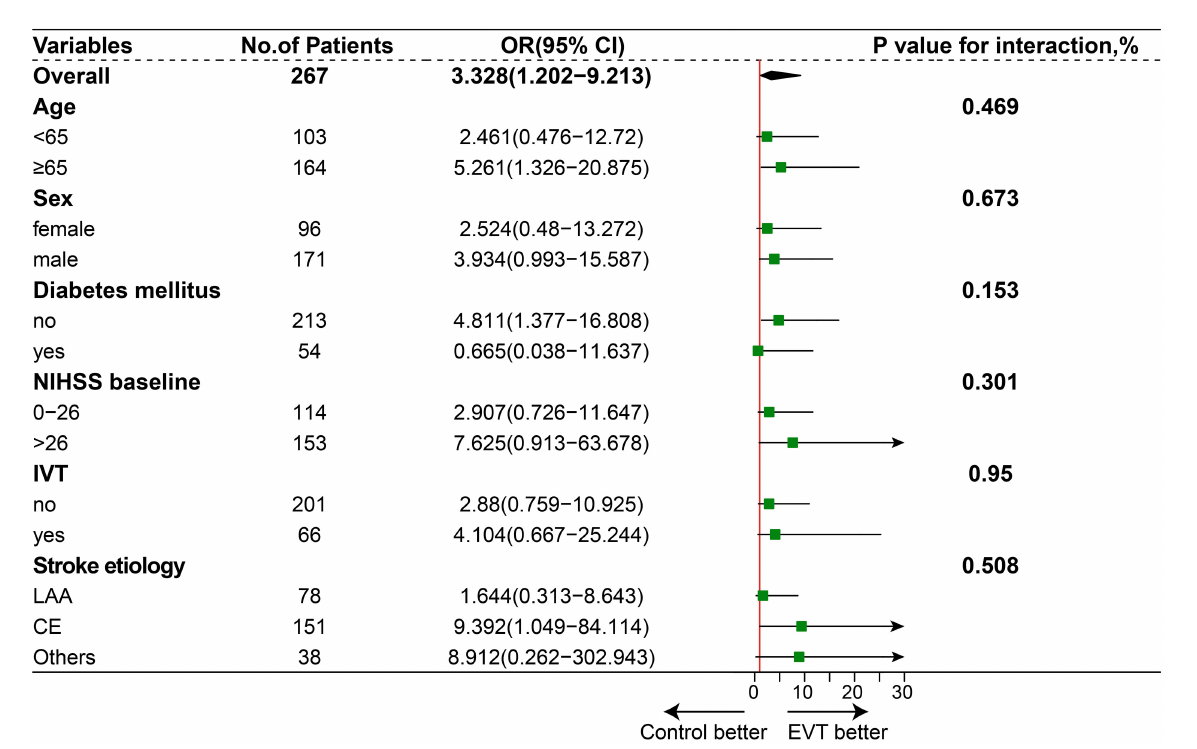
FIGURE4 Subgroup analysis. The forest plot shows the difference in odds ratio (OR) for favorable outcomes (defined as a modified Rankin scale score of 0–3) at day 90 in the subgroup. Adjusted variables were age, sex, National Institutes of Health Stroke Scale (NIHSS) score, diabetes mellitus (DM), and intravenous thrombolysis (IVT), stroke